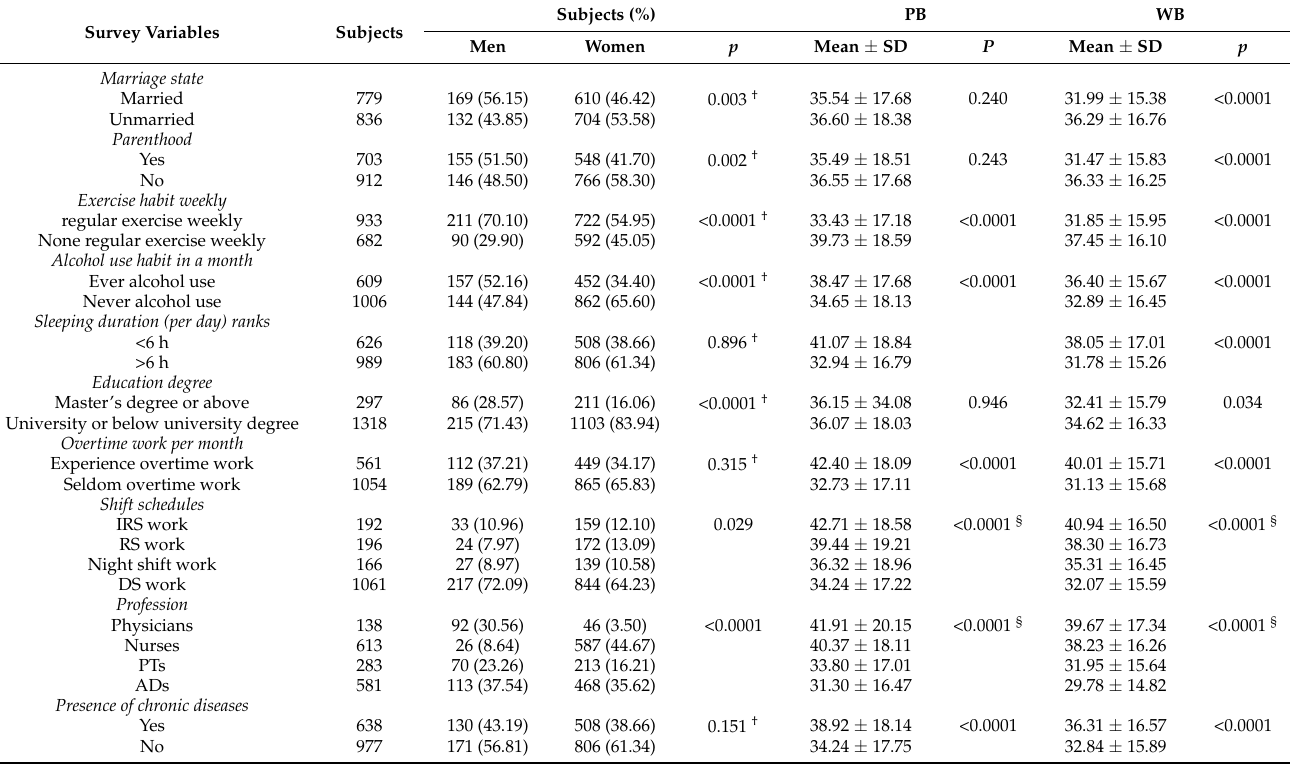
Table 2. Stratified analysis for sex and burnout.